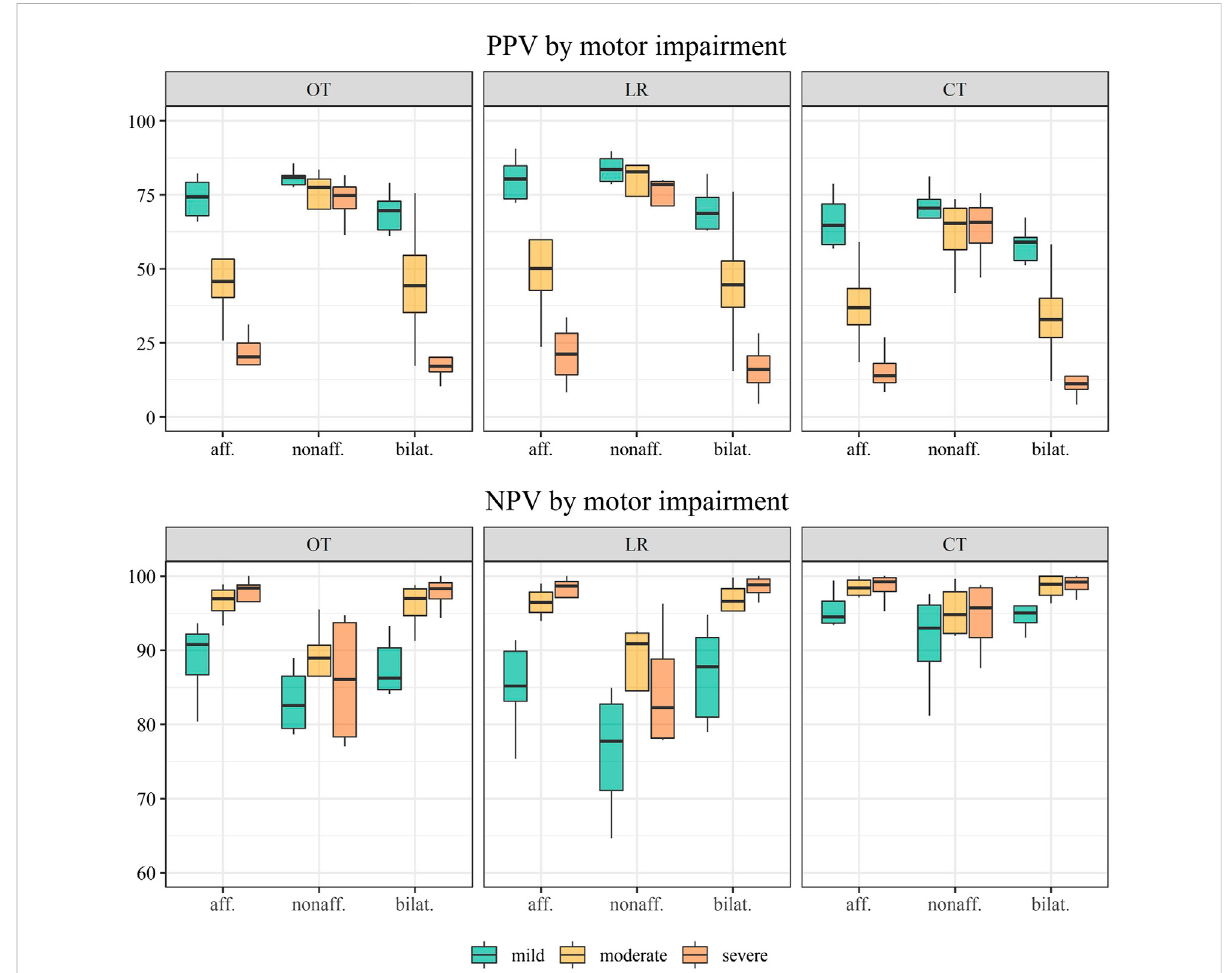
FIGURE 5 Distributionofthepositivepredictivevalue(PPV)andnegativepredictivevalue(NPV)acrossindividualsbymotorimpairmentlevels:mild(n=6), moderate (n = 4), and severe (n = 4). Classi fi cation methods displayed by panels: OT; optimal thresholds; LR, logistic regression; CT, conventional